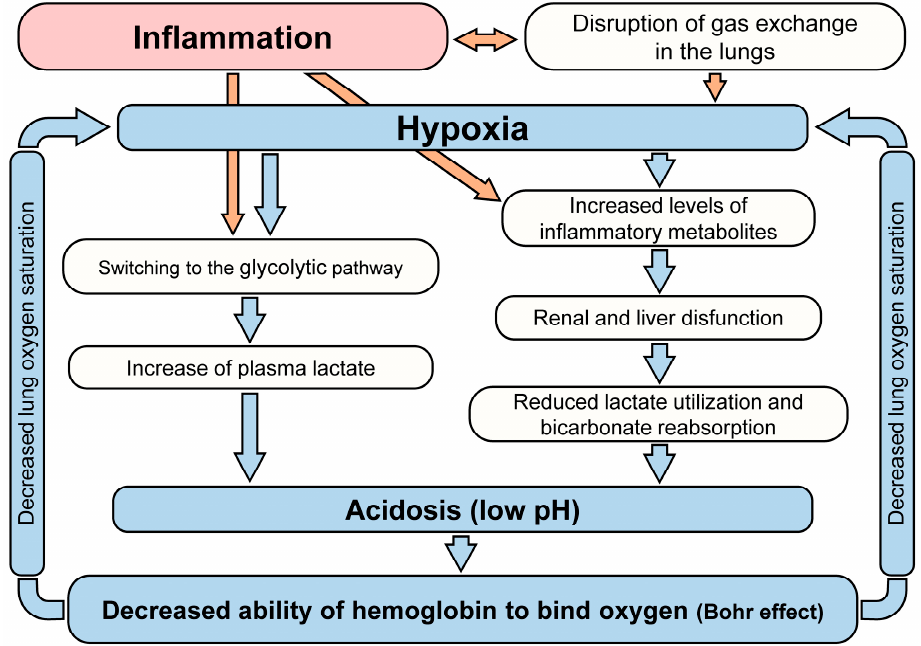
Figure 5. A diagram illustrating the system of direct and inverse relationships between inflammation, hypoxia, and saturation.